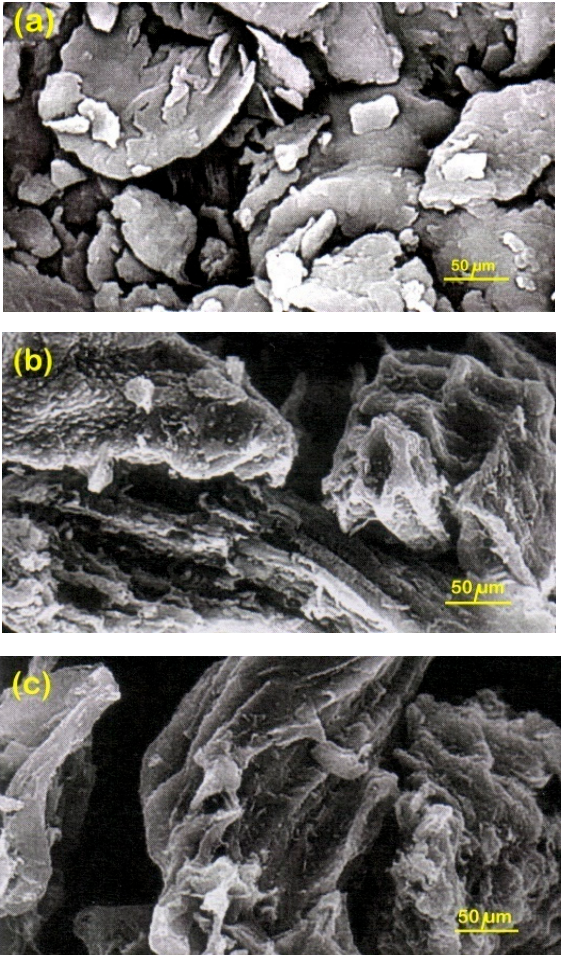
Figure 12. SEM images of: ( a )—wet walnut shells (WS w ); ( b )—wet walnut shell-based char (CWS w ) and ( c )—total dried walnut shell—based char (CWS TD ), reactor pyrolysis temperature of 800 °C.